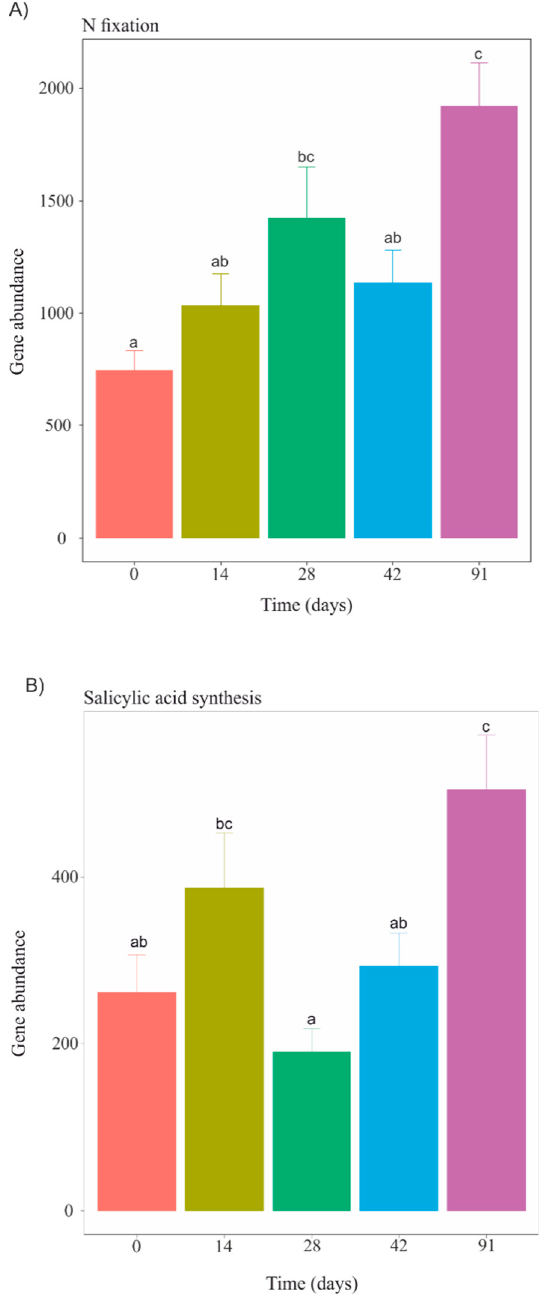
Figure 5. Changes in gene abundance of PICRUSt-predicted enzyme-level genes involved in nitrogen fixation ( A ) and synthesis of salicylic acid ( B ) during vermicomposting of grape marc derived from the red winemaking process of the grape variety Mencía. Letters indicate significant differences between time points (Tukey HSD test).